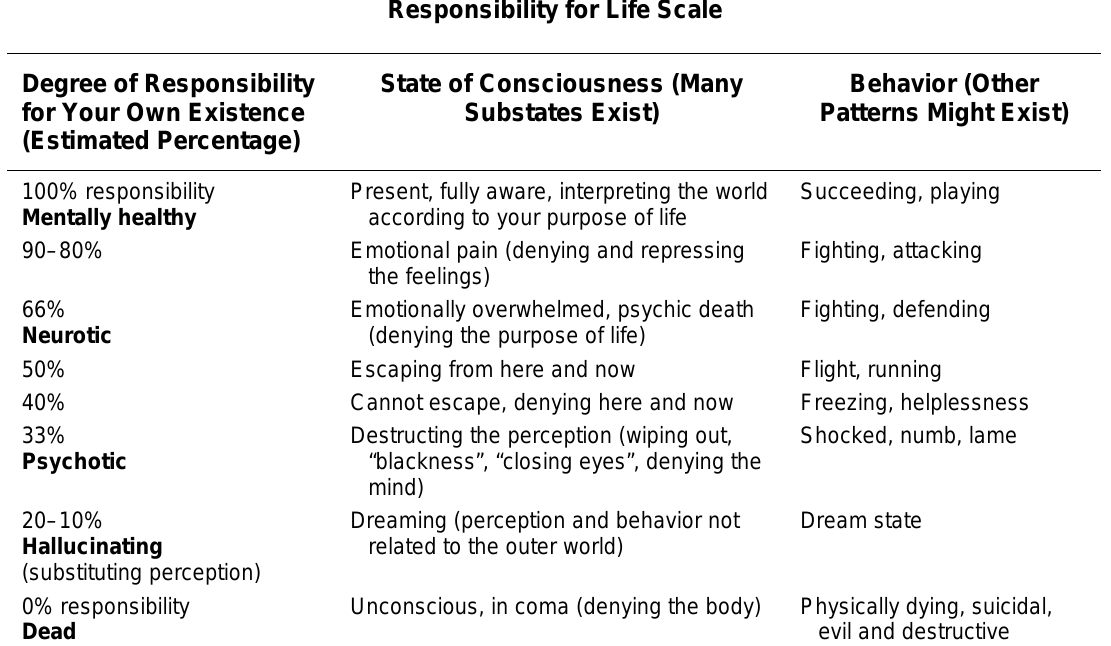
Responsibility for Life